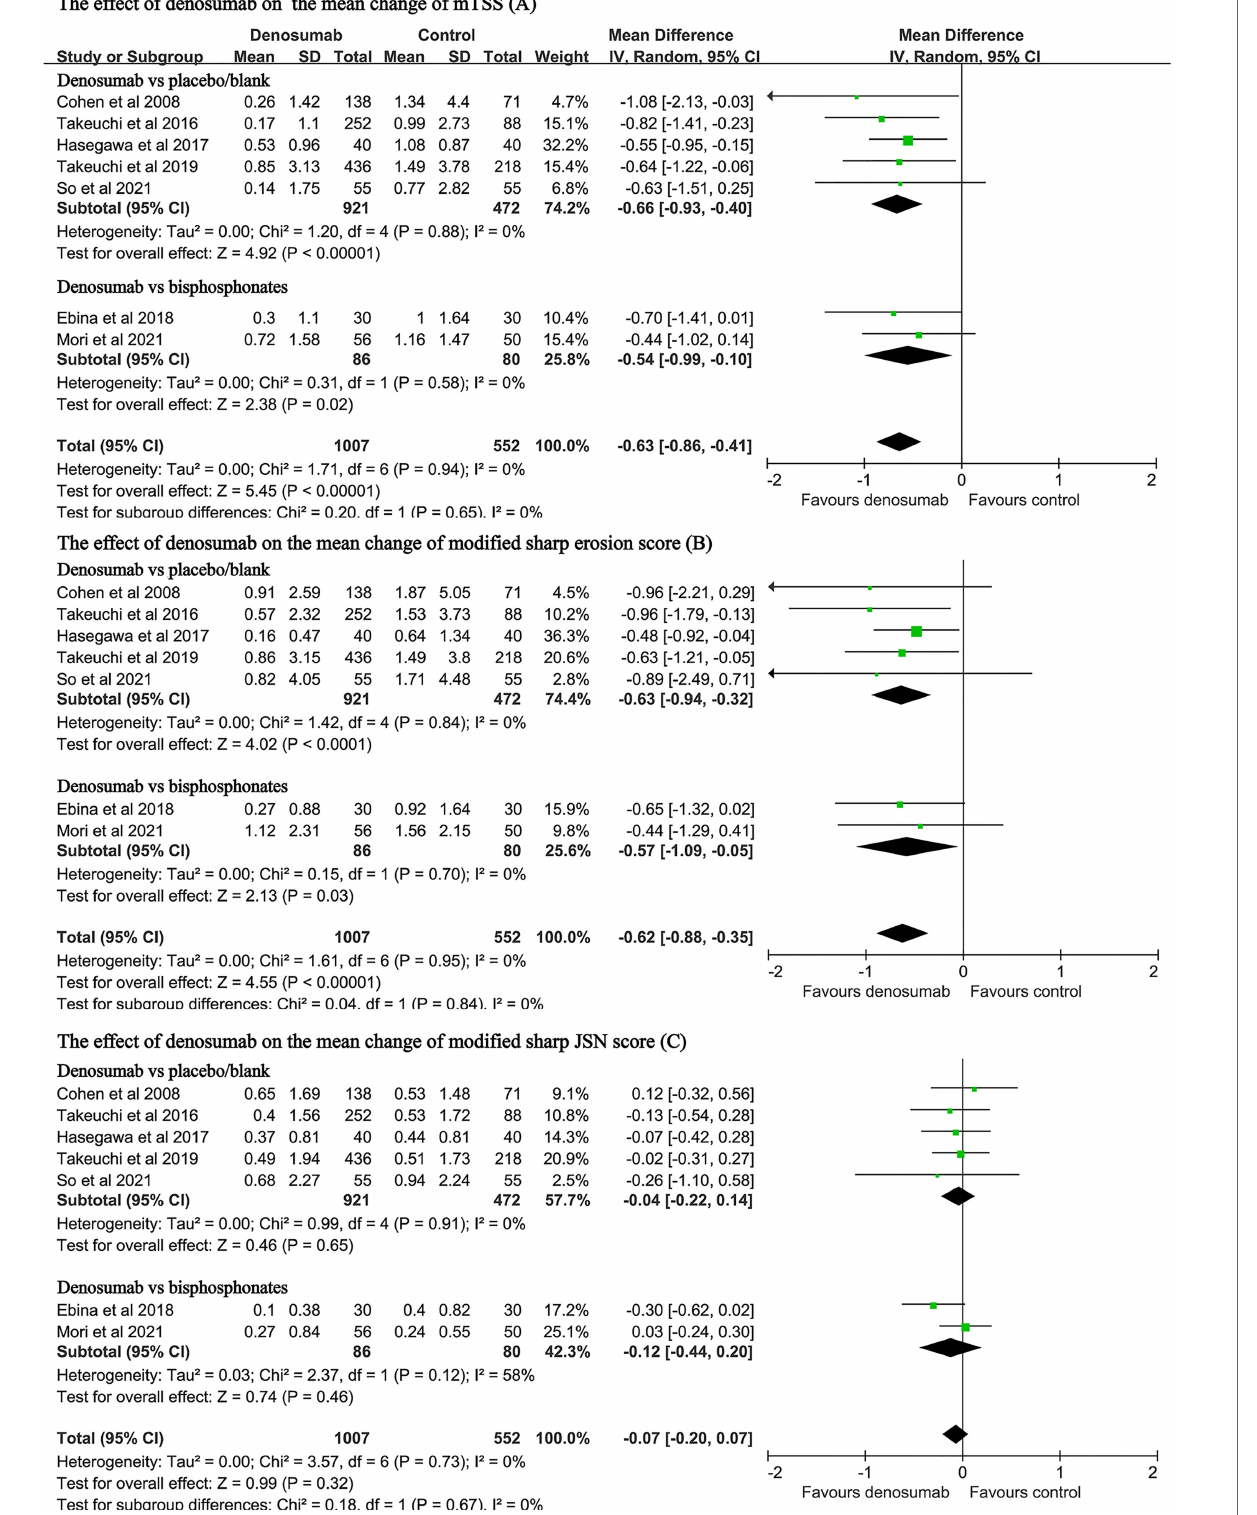
FIGURE 4 | Forest plot for the effect of denosumab on the changes in mTSS (A) , modi fi ed sharp erosion score (B) and modi fi ed sharp JSN score (C) .